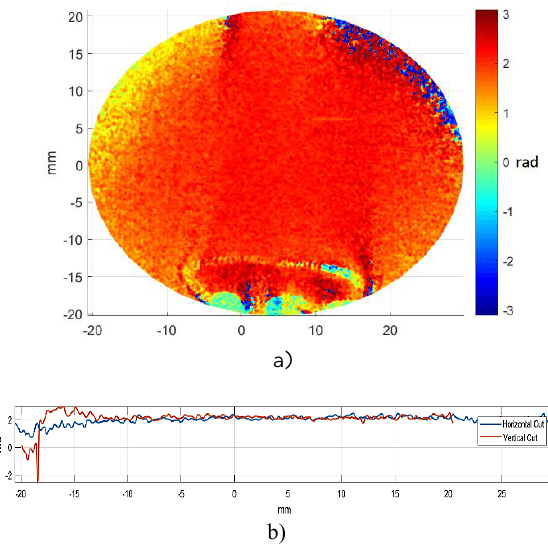
Fig.7. a) Synthetic phase field map at some time instant and b) phase profile run across the phase field. Fig.7. represents the fictional synthetic phase map which the CCD camera would have “seen” if a laser with wavelength 𝛬 would have been used. In our case, since 𝑒𝑞 the heat gradient wasn’t high, the synthetic phase map manifests itself with relatively smooth flat profile. It is worth noting that even the synthetic phase map can present phase jumps if the range of measurement is exceeded. The synthetic phase map however obscures phenomena that cause relatively small phase